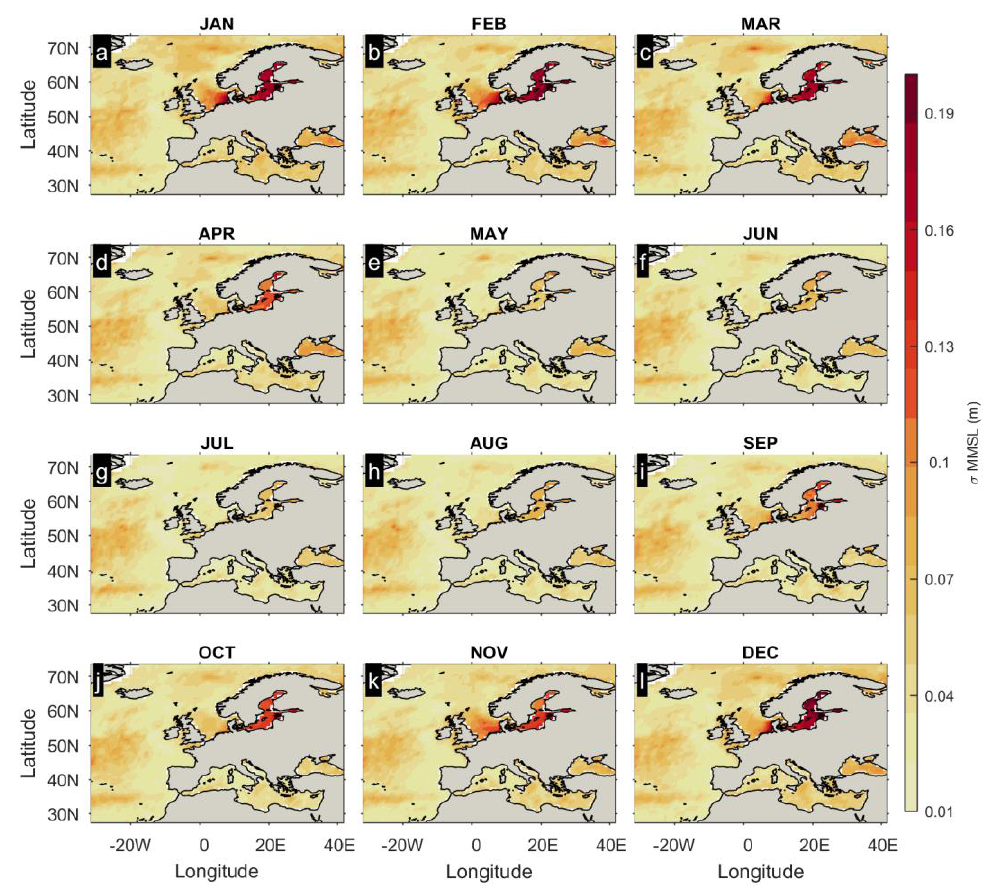
Figure 3. Seasonality of the standard deviation (σ) of monthly mean sea level (MMSL) (January-2a to December-2l)